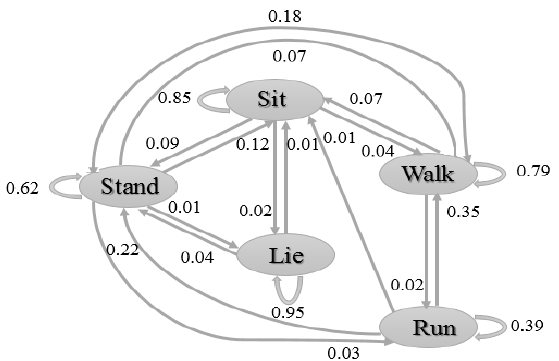
Figure 3. Transition probability graph (TPG) for five human activities. The oriented arcs between activity nodes represent the transition probability